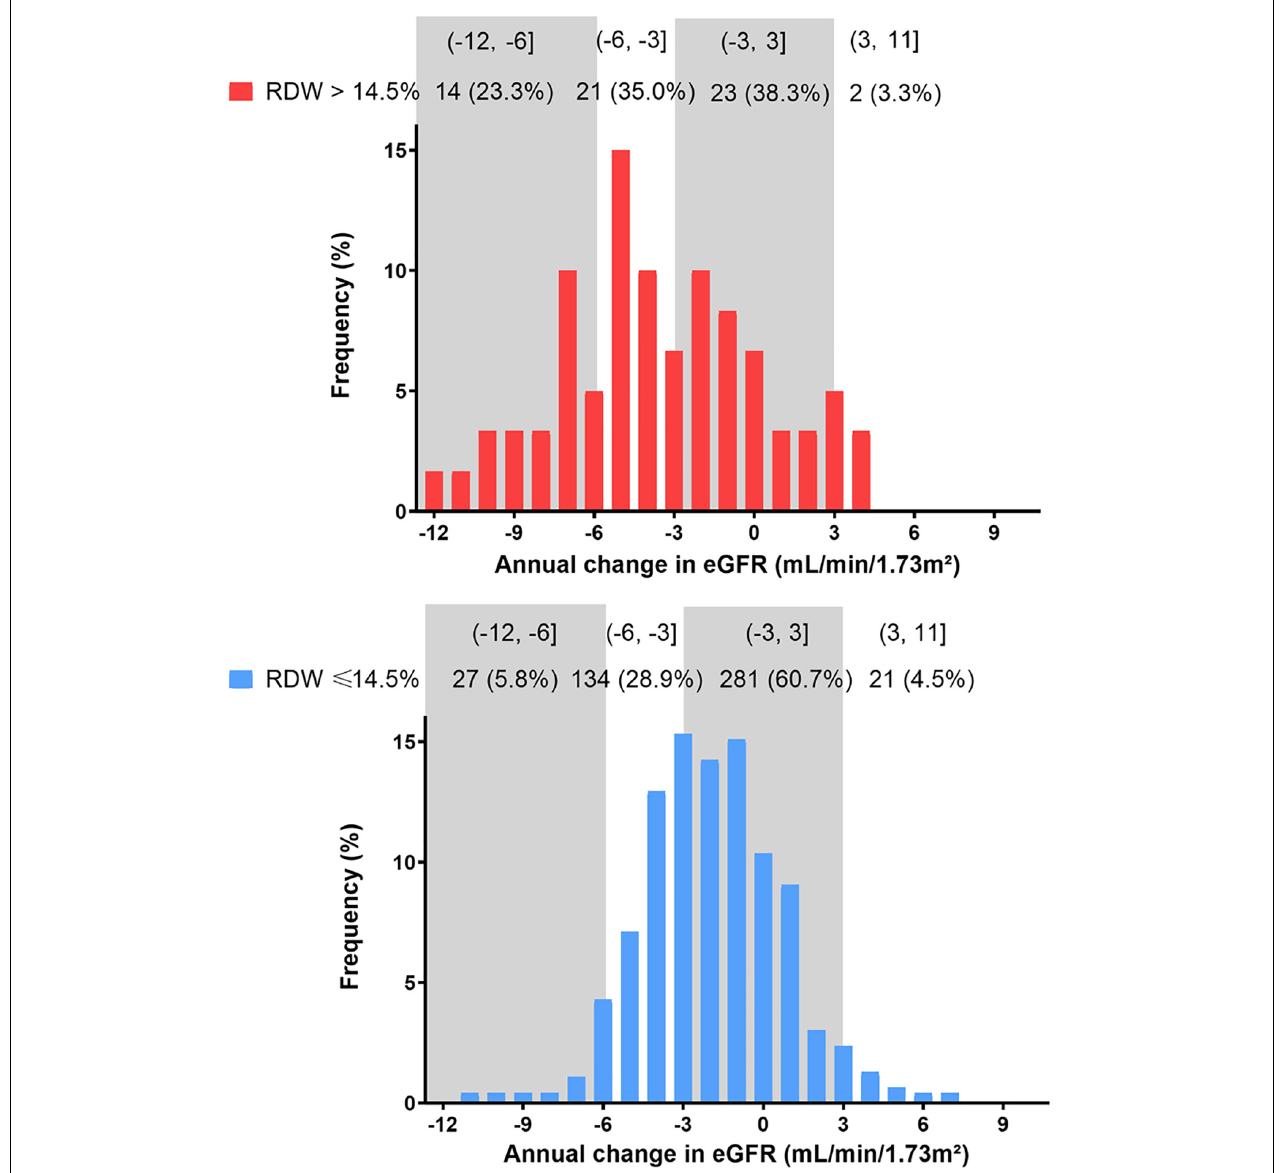
FIGURE 3 | Distribution of eGFR slope during the entire study period by RDW group. eGFR, estimated glomerular filtration rate.